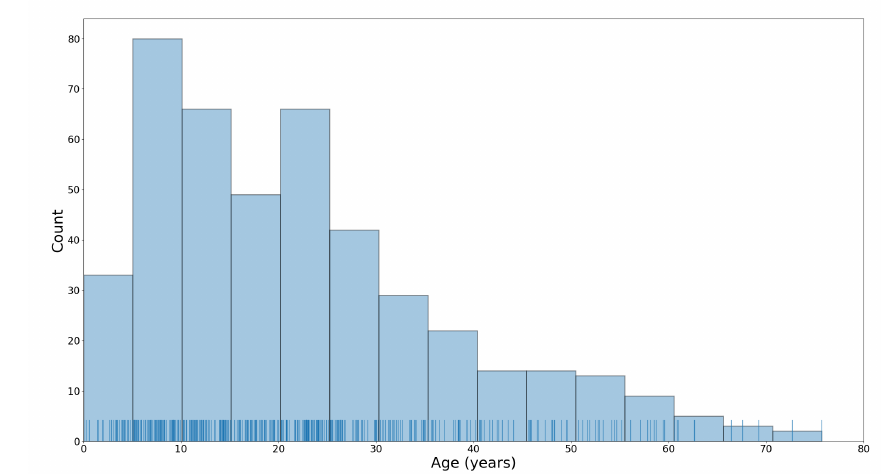
Figure 1. A histogram and rug plot of the test subject ages.